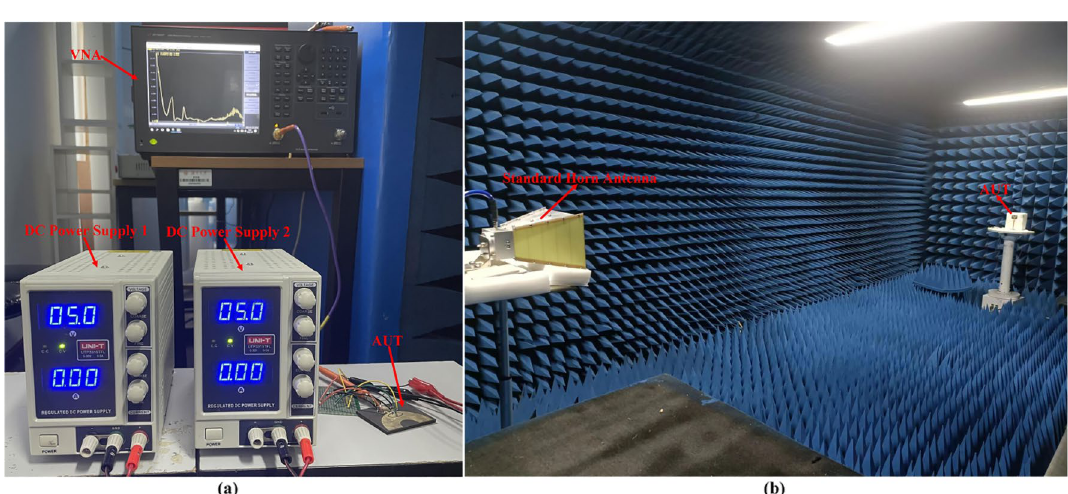
Figure 8. ( a ) Measurement of reflection coefficient of the proposed antenna with VNA. ( b )Anechoic chamber.